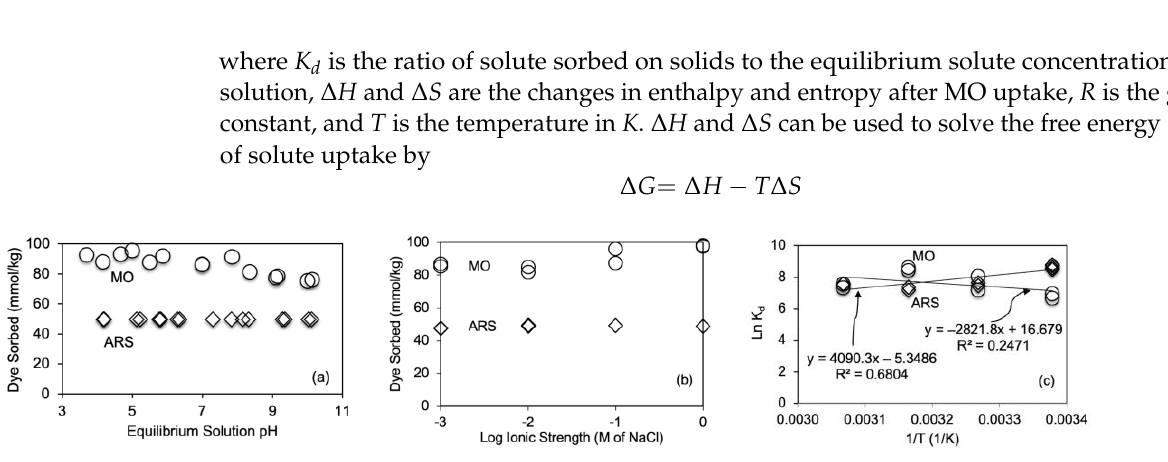
Figure 3. Influence of equilibrium solution pH ( a ), ionic strength ( b ), and temperature ( c ) on MO and ARS sorption on clinoptilolite. Table 1. Thermodynamic parameters of ARS and MO sorption on clinoptilolite.